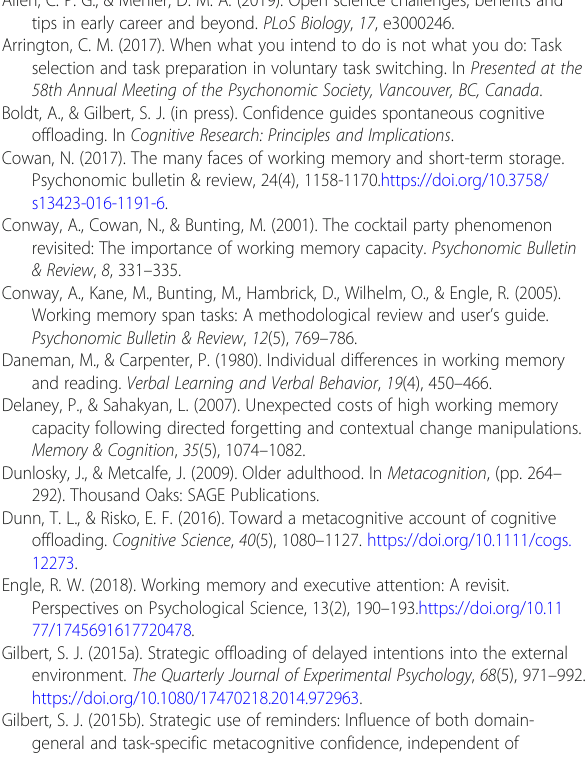
Abbreviation WMC: Working memory